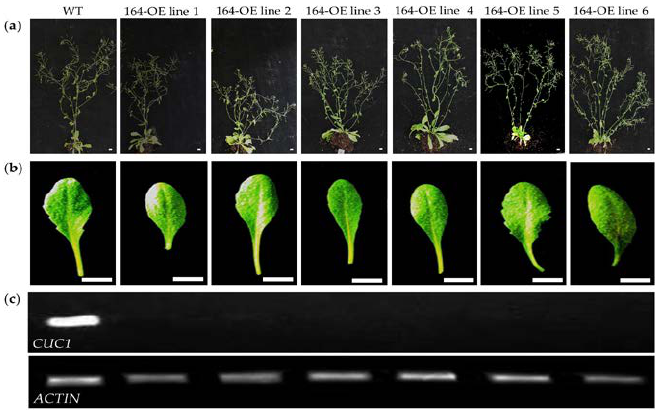
Figure 1. Phenotypic and molecular analyses of 164-OE Arabidopsis lines. ( a ) Adult plants of different 164-OE lines; ( b ) Leaves of different 164-OE lines; ( c ) Expression analysis of the CUC1 gene in the different 164-OE lines. RT-PCR was performed on cDNA of rosette leaves of the different lines. Scale bars = 1 cm.